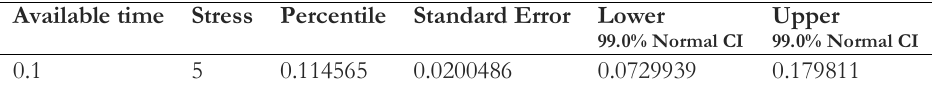
Table 7. The estimation of fatigue with PSFs